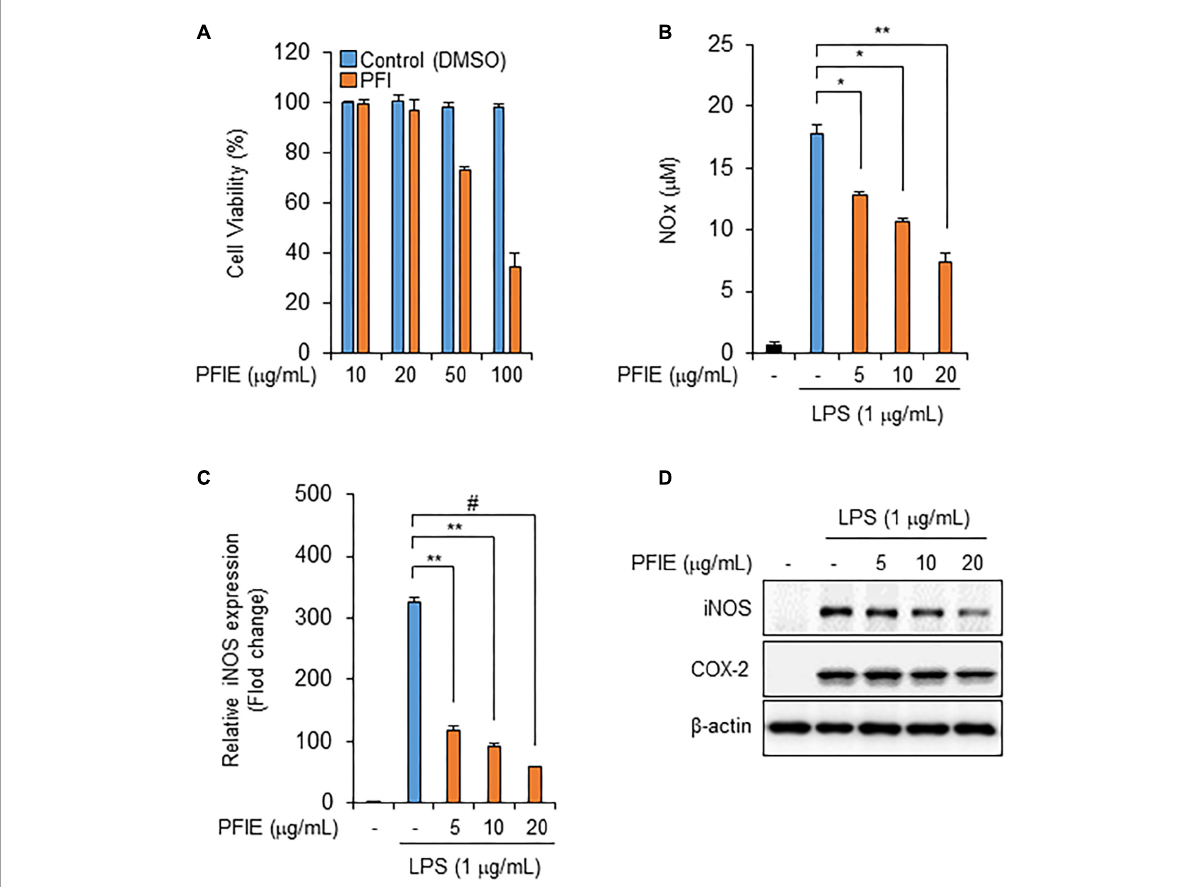
FIGURE1 PFIE suppresses LPS-induced NO production and iNOS expression in J774 macrophages. (A) Effect of PFIE on J774 cell viability was determined using WST-1 assay. (B) NO levels in culture media were measured using Griess reagent. (C) mRNA levels of iNOS were analyzed using real-time PCR. Relative mRNA expression levels were normalized to those of GAPDH. * P < 0.05, ** P < 0.01, and # P < 0.001 (Student’s t -test). Data are representative of three experiments. (D) Protein levels of iNOS were analyzed via